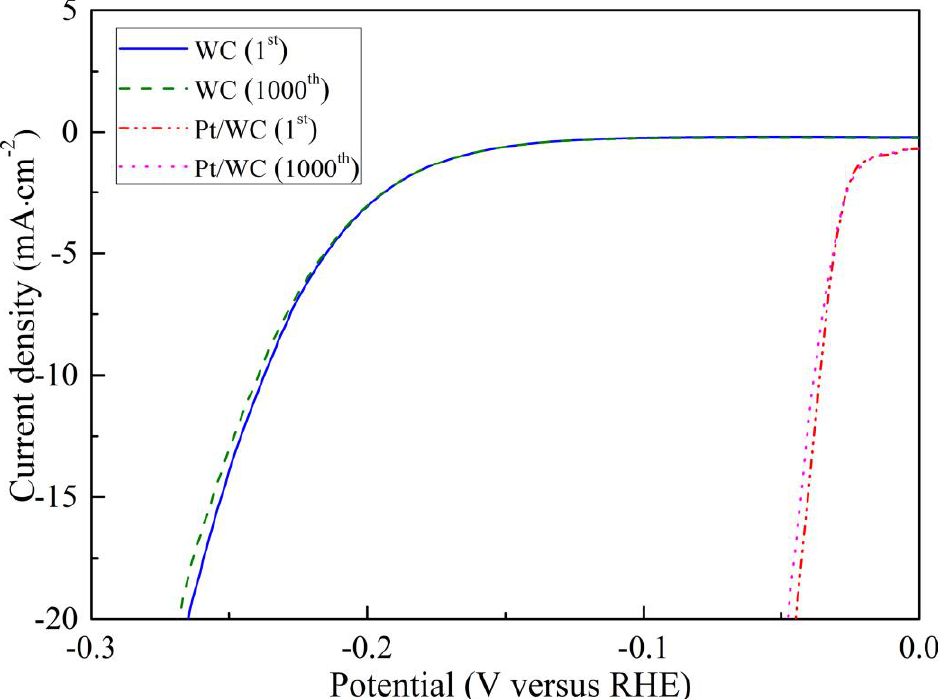
Figure 6. Polarization curves of WC and Pt/WC catalysts after continuous potential sweeps at 50 mV·s −1 in 0.5 M H 2 SO 4 solution.